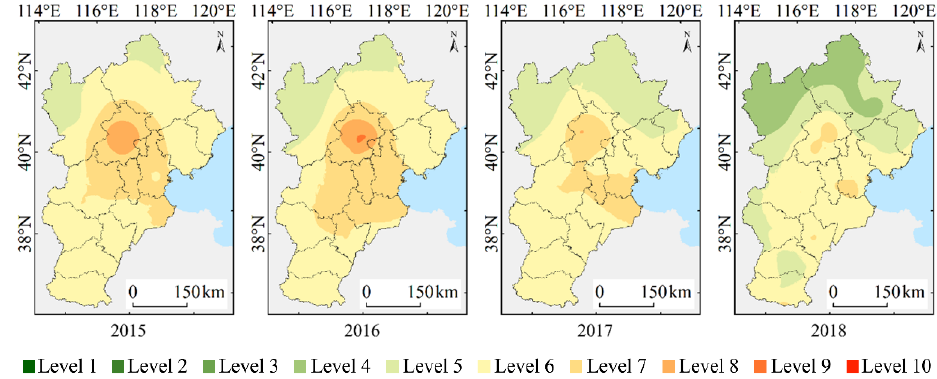
Figure 4. Spatial distribution of the annual mean value of the PM 2.5 /PM 10 ratio.